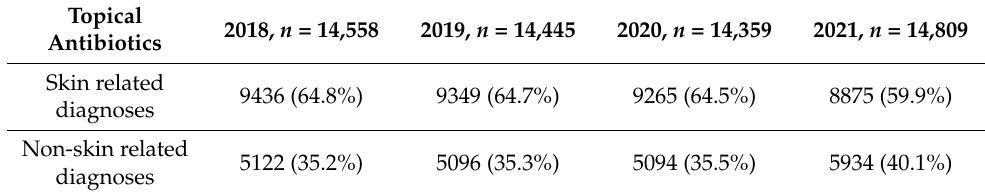
Table A4. Topical antibiotic prescriptions with skin and non-skin related diagnoses, 2018–2021.